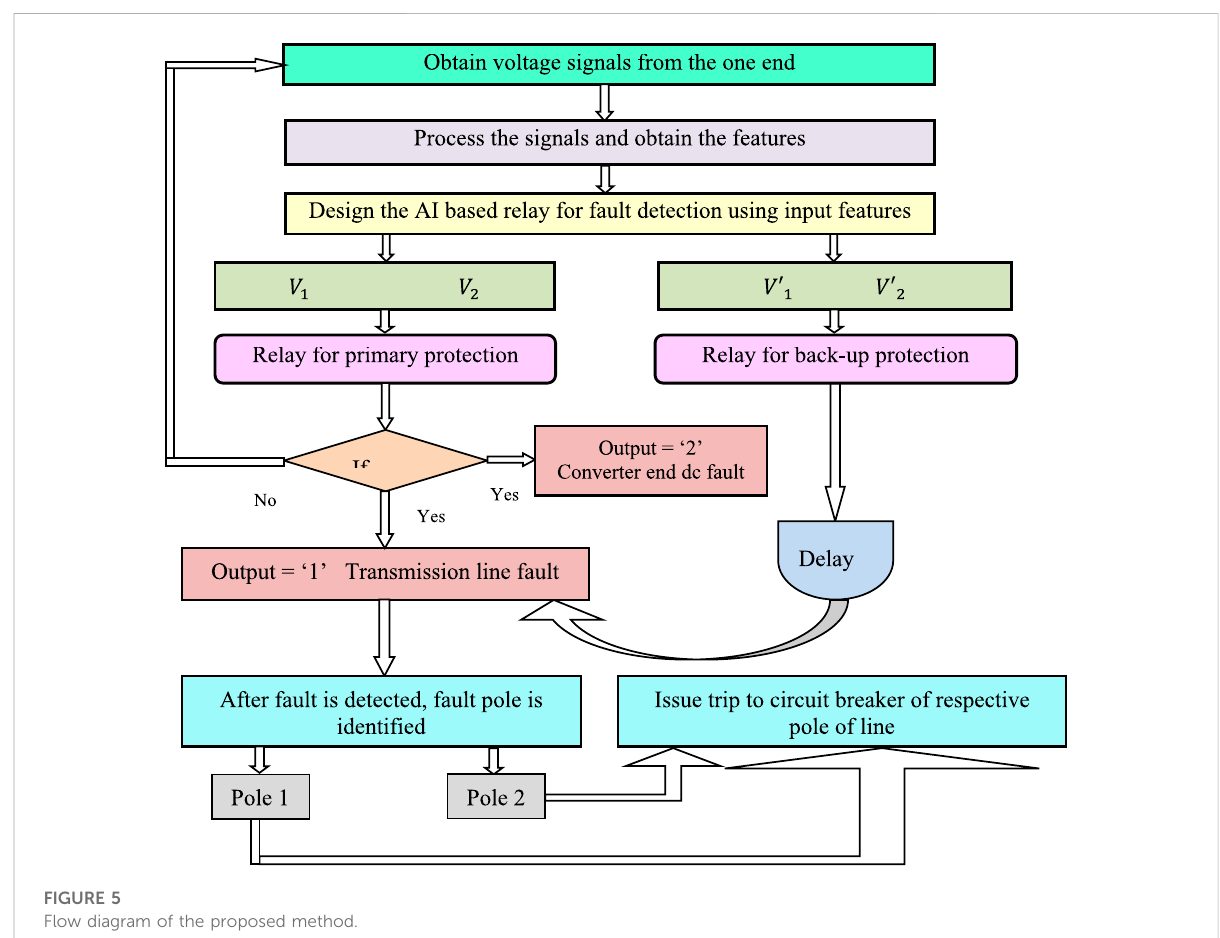
FIGURE 5 Flow diagram of the proposed